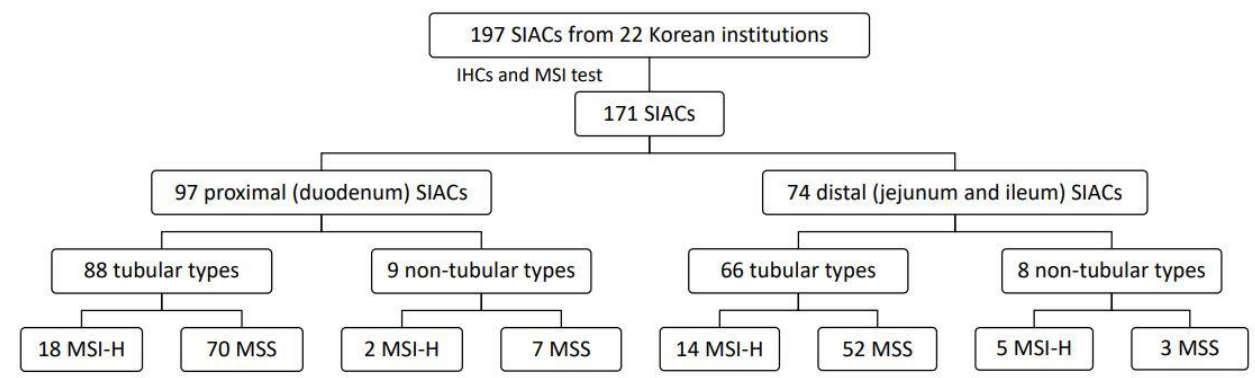
Figure 1. Flow chart of study population and tumor characteristics. SIAC, small intestinal adenocarcinoma; IHC, immuno- histochemistry; MSI, microsatellite instability—high; MSS, microsatellite stable.